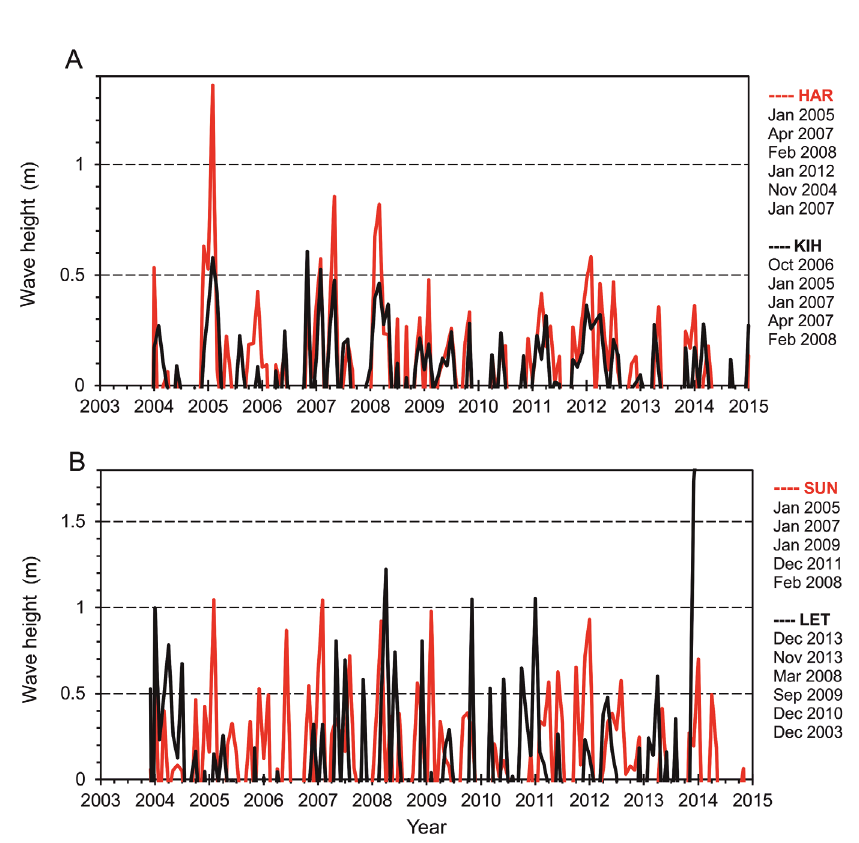
Fig. 7. Variations in monthly 99th percentiles after subtracting the corresponding seasonal cycles at Harilaid and Kihnu ( A ), and Sundgrund and Letipea ( B ) between October 2003 and December 2014. Only positive residuals are shown. The months with the highest waves are given on